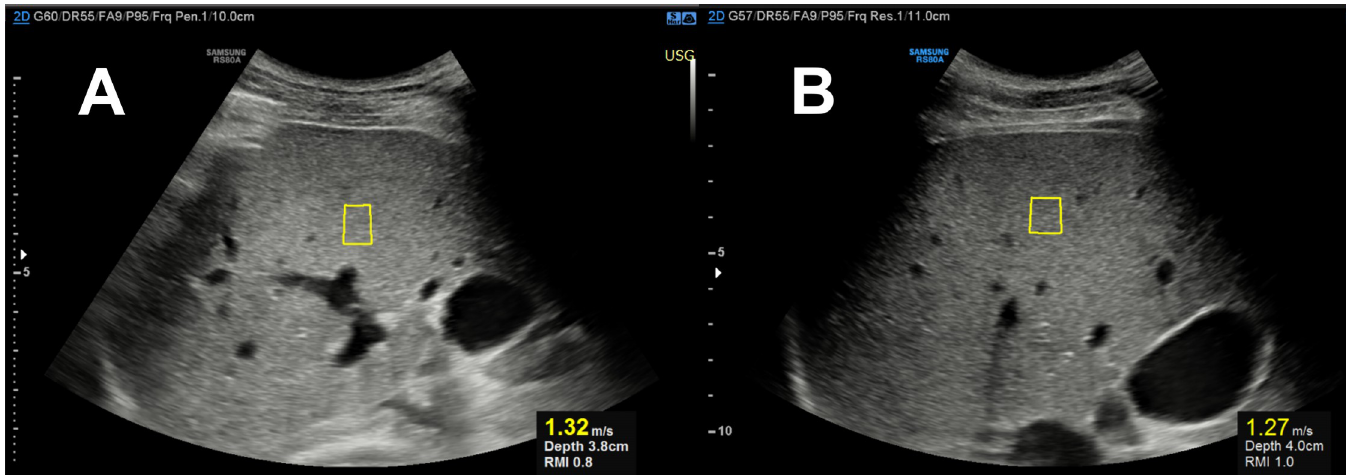
Fig 2. Right upper quadrant ultrasound of two patients using point shear-wave elastography technique. (A) A 48-year-old male patient, and (B), a 38-year-old male patient, both asymptomatic, 6 months after onset of severe yellow fever. Images depict placement of regions of interest (ROIs) on the right lobe of the liver at expiratory breath-hold. Shear-wave velocities (in m/s) were generated, with corresponding liver stiffness values after multiple measurements of 5.3 kPa and 4.6 kPa, respectively. Both subjects were then classified as F0/F1 on the Metavir scoring system for staging of fibrosis. RMI = Reliability measurement index. https://doi.org/10.1371/journal.pntd.0009594.g002 cardiogenic liver congestion on Doppler analysis. All remaining patients had Doppler evalua- tion of superior abdomen (portal vein, hepatic veins and hepatic artery) within normal ranges. No patient showed morphologic changes of cirrhosis on grayscale mode ( Table 1 ). Table 2 compares clinical and demographic variables and laboratory results at admission with LS values obtained 6 months after onset of symptoms. Heart failure was associated with increased LS ( p = 0 . 024 ); systemic arterial hypertension and diabetes showed a tendency towards this association (p = 0 . 063 and p = 0 . 066 , respectively). After exclusion of the outlier patient (LS = 22,4 kPa, with cardiogenic liver congestion), there was a tendency towards statis- tical significance in the correlations between LS and age ( ρ = 0.416, p = 0 . 096 ) and between LS and alanine aminotransferase at admission ( ρ = -0.479, p = 0 . 052 ) ( Fig 3 ). We found no